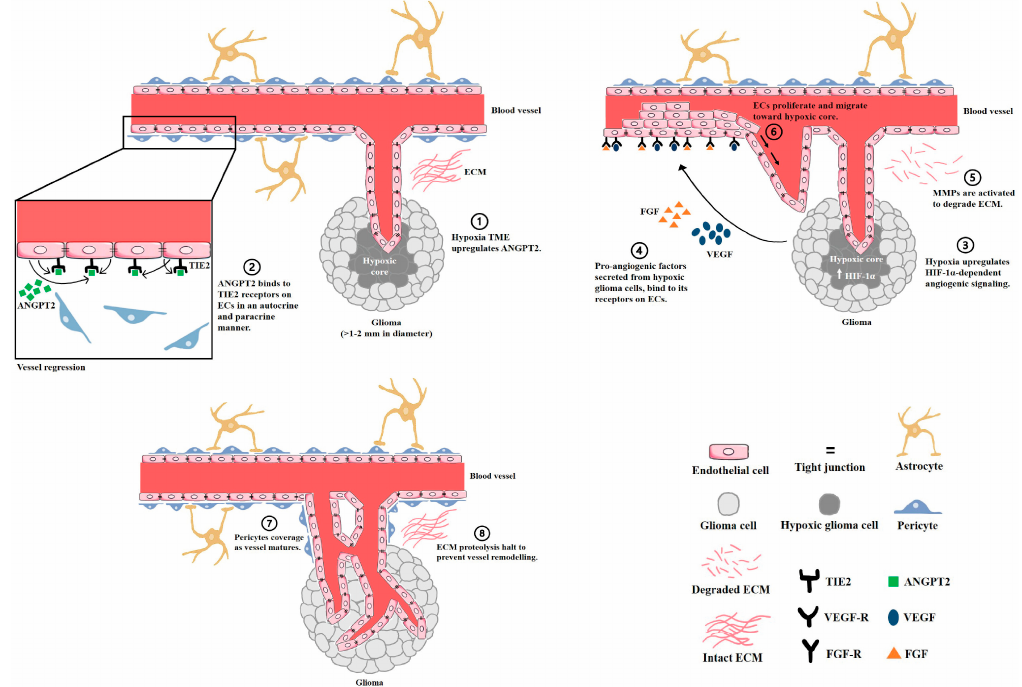
Figure 1. Schematic representation of glioma angiogenesis. As tumor growth within the brain parenchyma goes beyond 1–2 mm in diameter, its metabolic demands cannot be met entirely via diffusion. (1) Hypoxia then occurs to regulate angiogenic signals. (2) The activation of autocrine and paracrine ANGPT2/TIE2 signaling subsequently disrupts endothelial–mural cell interactions for vessel regression. (3,4) HIF-1 α upregulation induces the transcriptional activation of proangiogenic molecules that initiate EC proliferation and migration. (5) Simultaneously, increased ANGPT2 activates MMP-2 to degrade the ECM. (6) Proteolysis of the vessel’s basement membrane facilitates the migration and proliferation of ECs toward the hypoxic tumor core. Lastly, the blood vessel wall matures, as (7) pericytes are recruited along the ECs to stabilize the blood vessel. (8) Endogenous protease inhibitors and antiangiogenic factors locally halt ECM proteolysis to hinder further vessel remodeling.